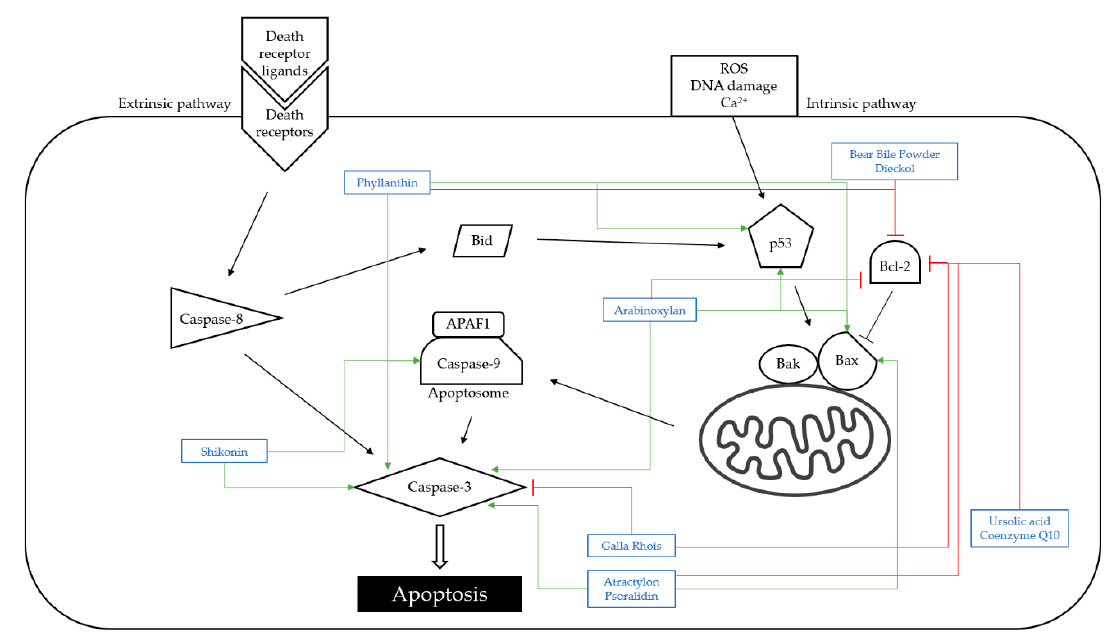
Figure 1. Schematic diagram of apoptosis pathway. The extrinsic pathway starts with covalent bonds of death receptors and ligands, which activate caspase-8 and caspase-3 sequentially to lead to apoptosis. The intrinsic pathway passes through p53 and mitochondria to the apoptosome, which is a combination of APAF 1 and caspase-9 and leads to the cell death. This process is upregulated by the pro-apoptotic proteins such as Bax, Bak, Bid and downregulated by anti-apoptotic proteins such as Bcl-2, Bcl-xL. Caspase-9 was regulated by shikonin, and caspase-3 was controlled by shi-